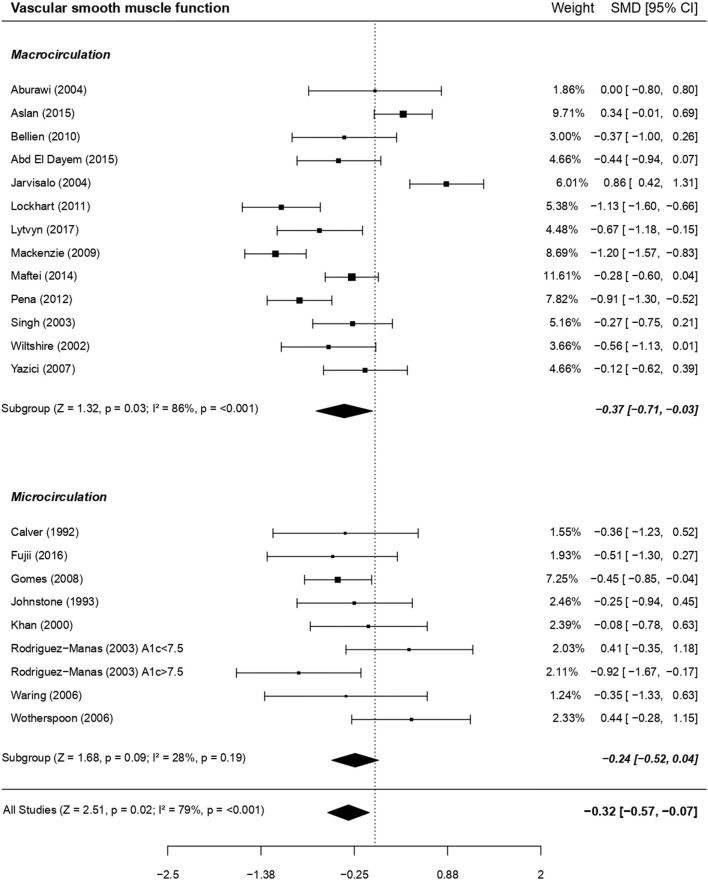
Forest plot of studies on VSM function in subjects with type 1 diabetes vs. controls. For each subgroup, the following values are indicated: Z and p-value; I2, heterogeneity and p for heterogeneity. There was no difference between macro and microcirculation (with metaregression for qualitative data: moderator P = 0.60).